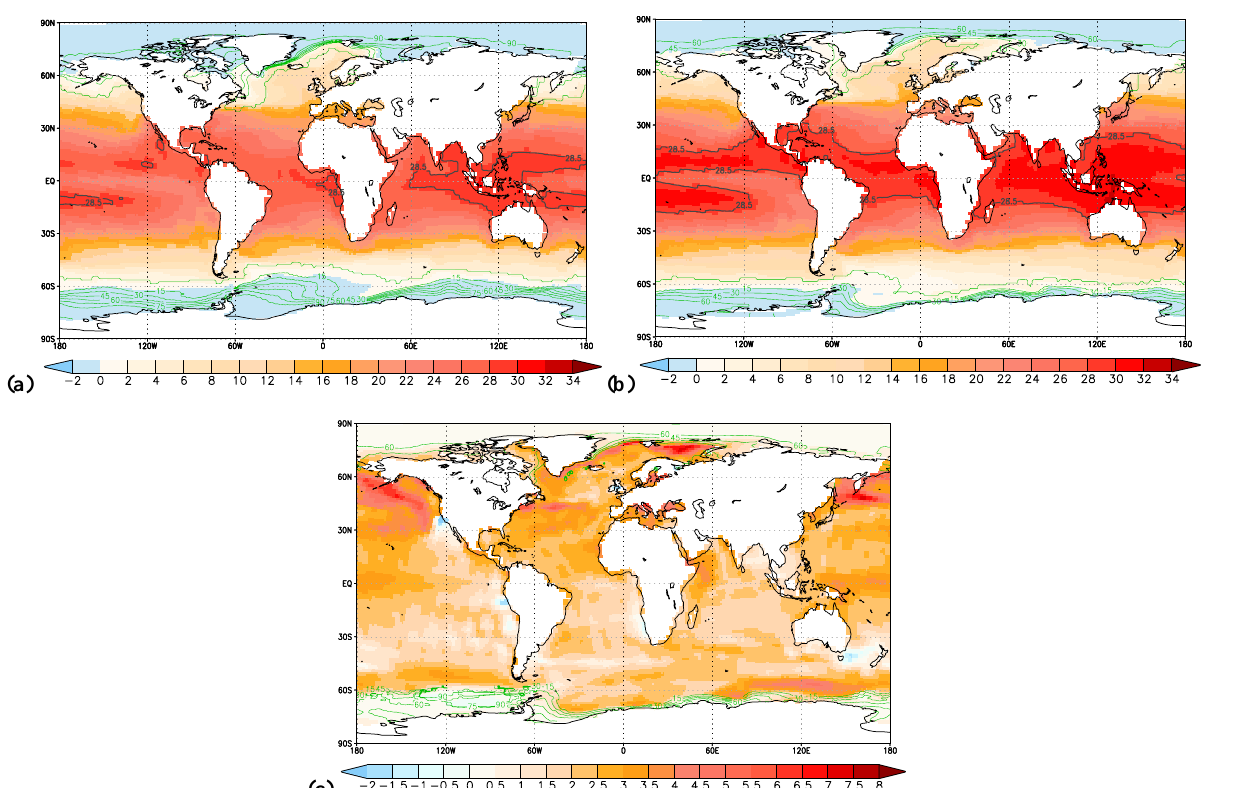
Fig. 12. Annual mean SST in ◦ C in experiment 2 for the PI control simulation (a) , the mid-Pliocene simulation (b) , and the anomaly between mid-Pliocene and PI control (c) . The expansion of the equatorial warm pool is indicated by the bold grey 28.5 ◦ C isoline (a, b) . In addition to the SST fields, we show in (a, b) thin green isolines depicting the absolute values of fractional sea ice cover. The contour interval is 0 . 15. The percentage of PI sea ice cover that is still available at a specific location in the mid-Pliocene simulation is indicated by thin green isolines in (c) . The contour interval is 0 . 15. All values represent time averages calculated from a 30-yr climatology that has been interpolated to a regular 360 ◦ × 180 ◦